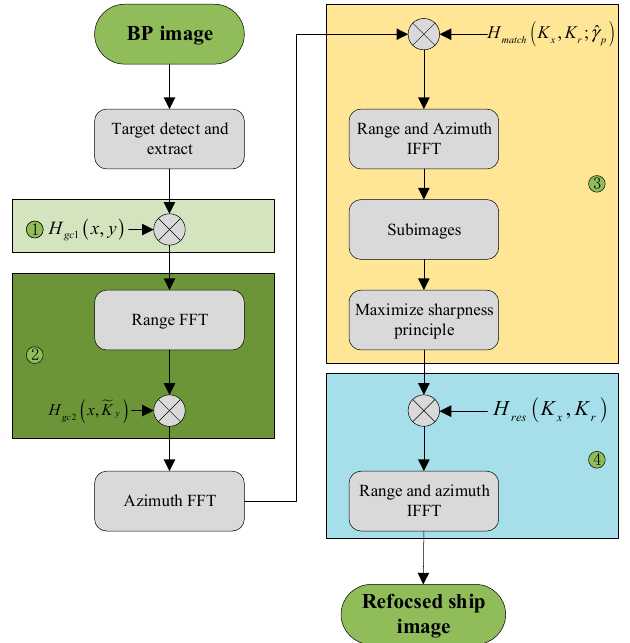
γ . 4. Perform motion compensa- p